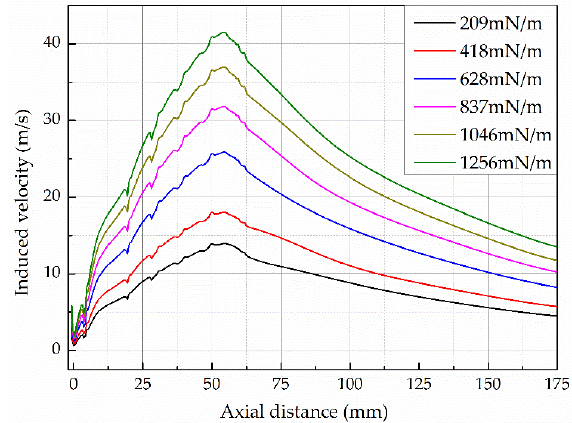
Figure 4. Distribution of induced velocity by six plasma actuators in quiescent air with different body forces of plasma actuators.